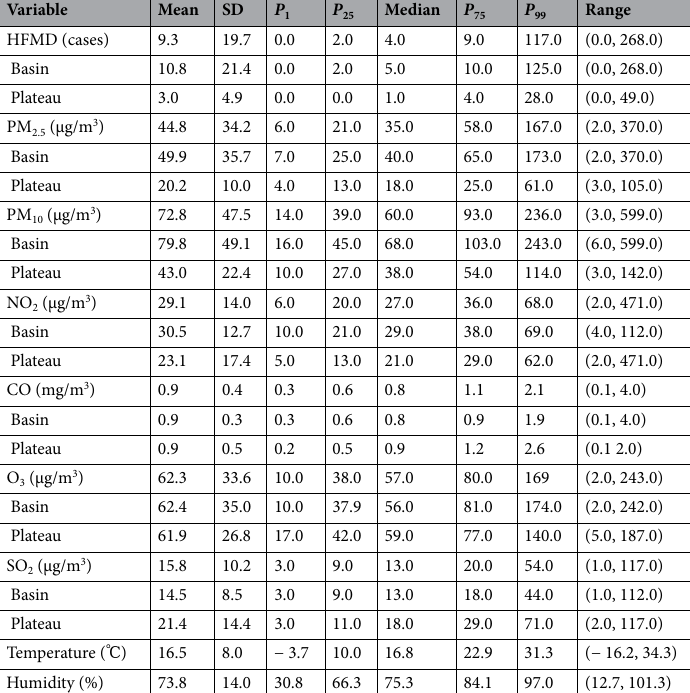
Table 1. Descriptions of daily HFMD cases, air pollutants, and meteorological variables in Sichuan Province from 2015 to 2017. P1, p25, p75, and p99 represent the 1st, 25th, 75th, and 99th percentiles of each variable,